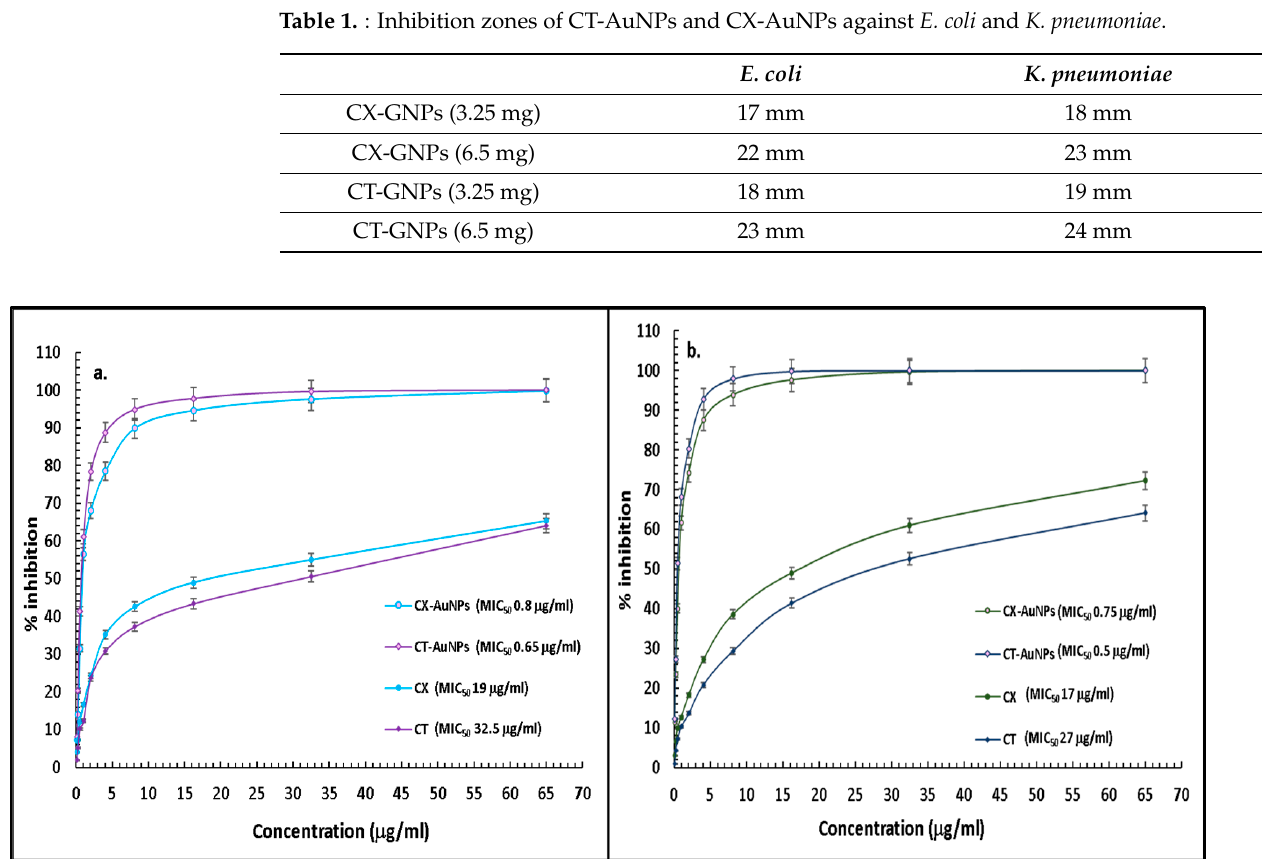
Figure 7. MIC graph of pure CT, pure CX, CT-AuNPs and CX-AuNPs against ( a ). E. coli and ( b ). K. pneumoniae.